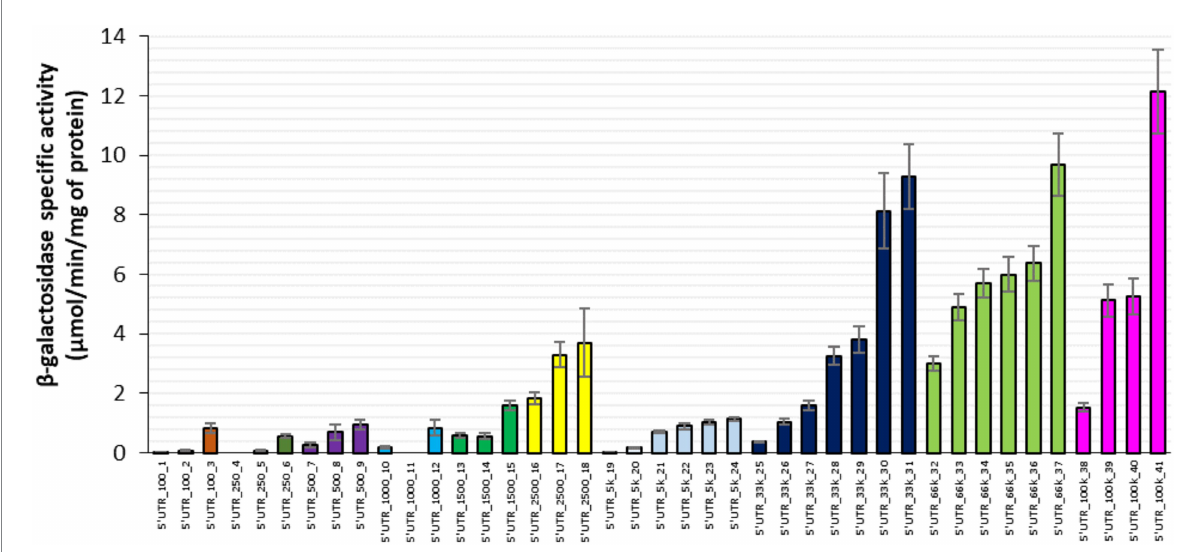
FIGURE 1 β -galactosidase activity associated with 41 synthetic 5’UTRs ordered by RBS index from 100 to 100,000 AU. Each cluster of columns with the same color corresponds to a specific RBS index series. Error bars represent standard deviations ( n =